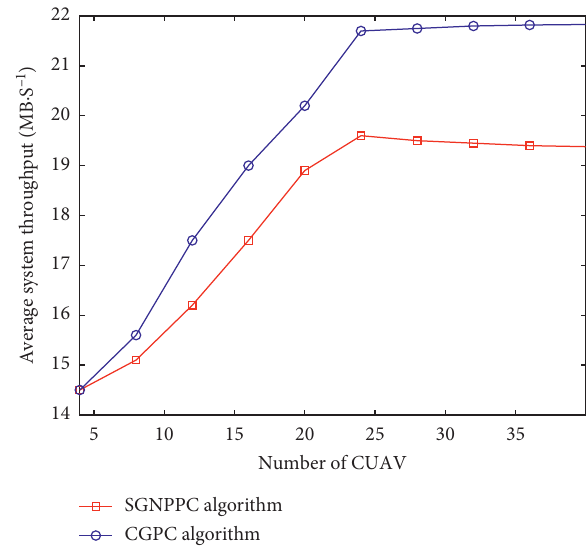
Figure 4: Transmitted power for the system average throughput CUAV for different algorithms.